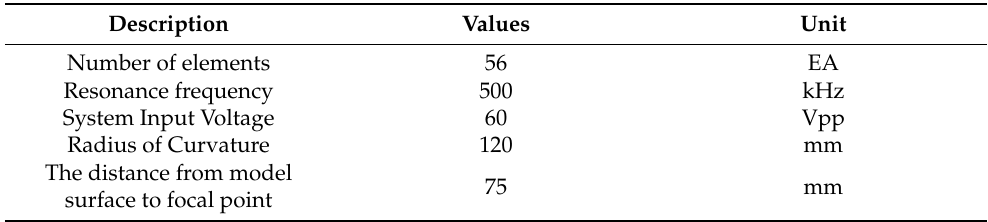
Table 1. Specification of the 56-channel